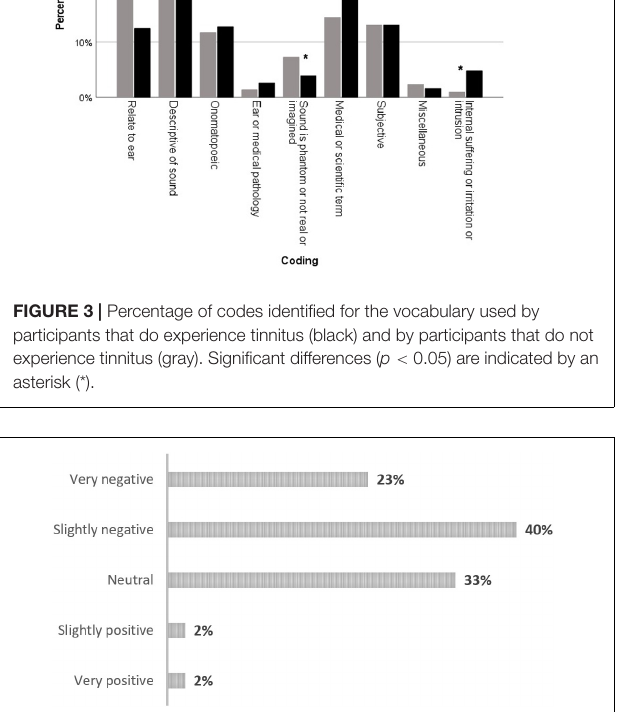
FIGURE 4 | Conations of the words and phrases according to the participants themselves.